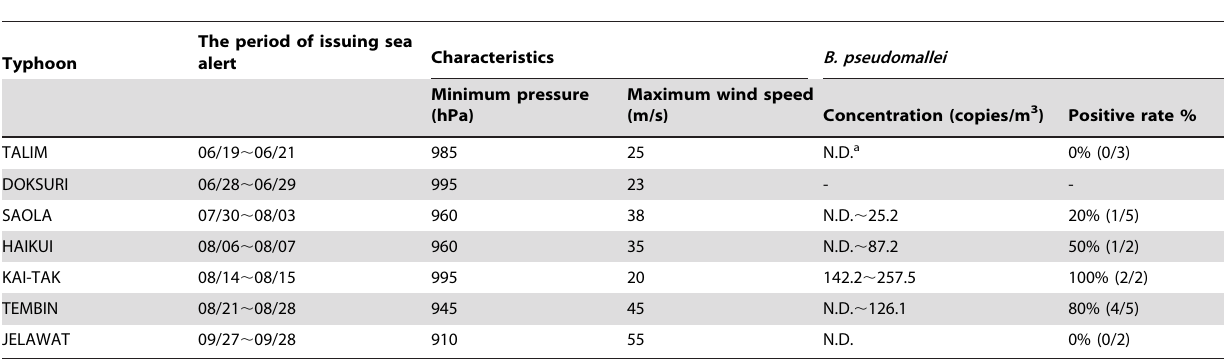
Table 1. Ambient B. pseudomallei and environmental characteristics during typhoon-affecting-period in 2012 in Taiwan.